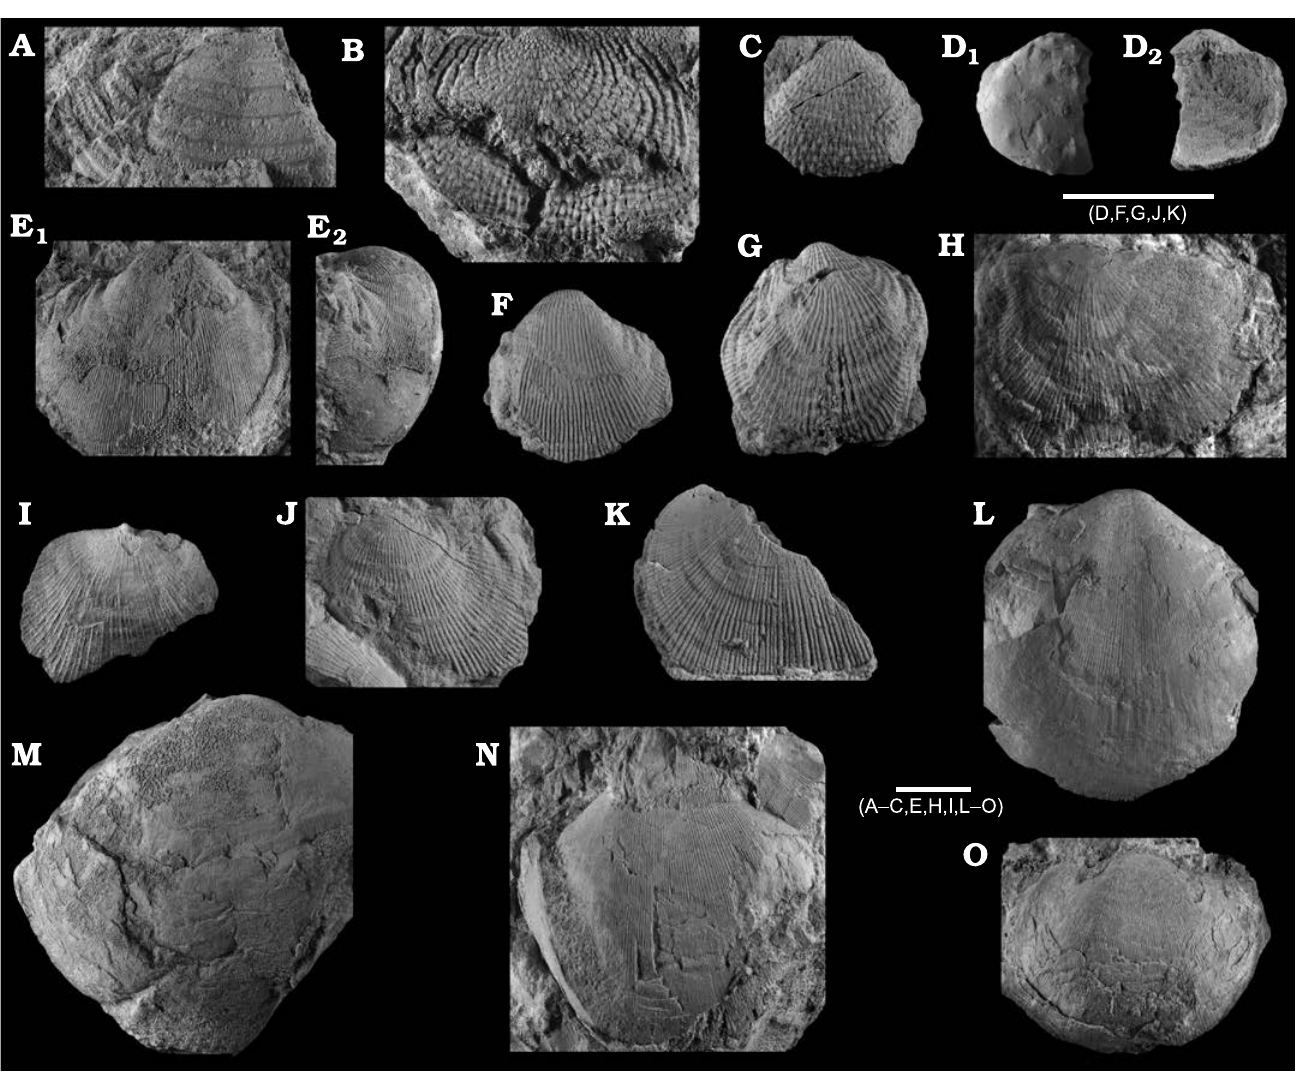
Fig. 13. Echinoconchidae, Linoproductidae, Monticuliferidae, Orthotetida, and Orthida from the Brigantian (uppermost Visean) of Ricklow Quarry, near Monyash, Derbyshire, UK (localities RCC-, RCK-; see Fig. 3). A . Echinoconchus punctatus (Sowerby, 1822), MPUM11976 (RCK15-47) in ventral view. B – D . Pustula cf. pustulosa (Phillips, 1836), B . MPUM11989 (RCC128-17a) dorsal valve external cast. C . MPUM11987 (RCC41-1) in ventral view. D . MPUM11988 (RCC128-7) in ventral (D 1 ) and dorsal (D 2 ) views. E , F . Linoprotonia sp. E . MPUM11991 (RCC42-17) in ventral (E 1 ) and lateral (E 2 ) views. F . MPUM11992 (RCC60-59) in ventral view. G . Fluctuaria undata (Defrance, 1826), MPUM11926 (RCC300-14) ventral valve in ventral view. H . ? Serratocrista aff. dalriensis McIntosh, 1974, MPUM11997 (RCC10-40) ventral valve in ventral view. I . Schellwienella sp., MPUM11995 (RCC36-12) ventral valve in ventral view. J , K . Schizophoria ( Schizophoria ) cf . connivens (Phillips, 1836). J . MPUM12009 (RCC60-48) in ventral view. K . MPUM12010 (RCC1B-7) dorsal valve in dorsal view. L – O . Schizophoria ( Schizophoria. ) resupinata (Martin, 1809). L . MPUM12003 (RCC1B-4) dorsal valve in dorsal view. M . MPUM11999 (RCC1B-26) in dorsal view. N . MPUM12004 (RCC1B-25) dorsal valve in dorsal view. O . MPUM12005 (RCC36-1a) dorsal valve in dorsal view. Scale bars 10